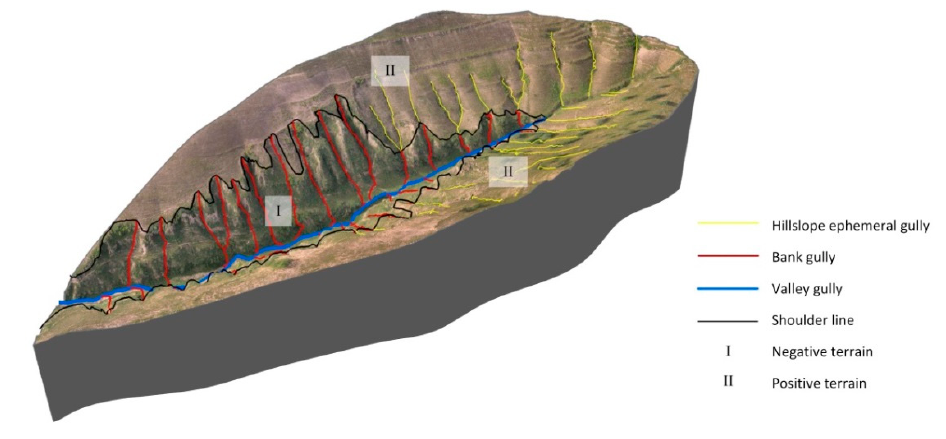
Figure 1. Typical gully system in loess hilly area of China.